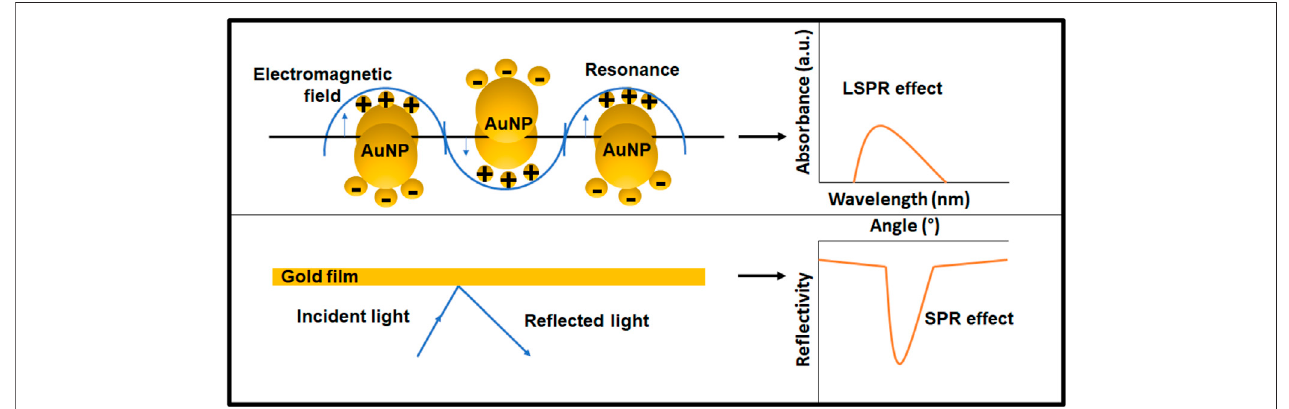
FIGURE 5 | The principal of SPR and LSPR sensing